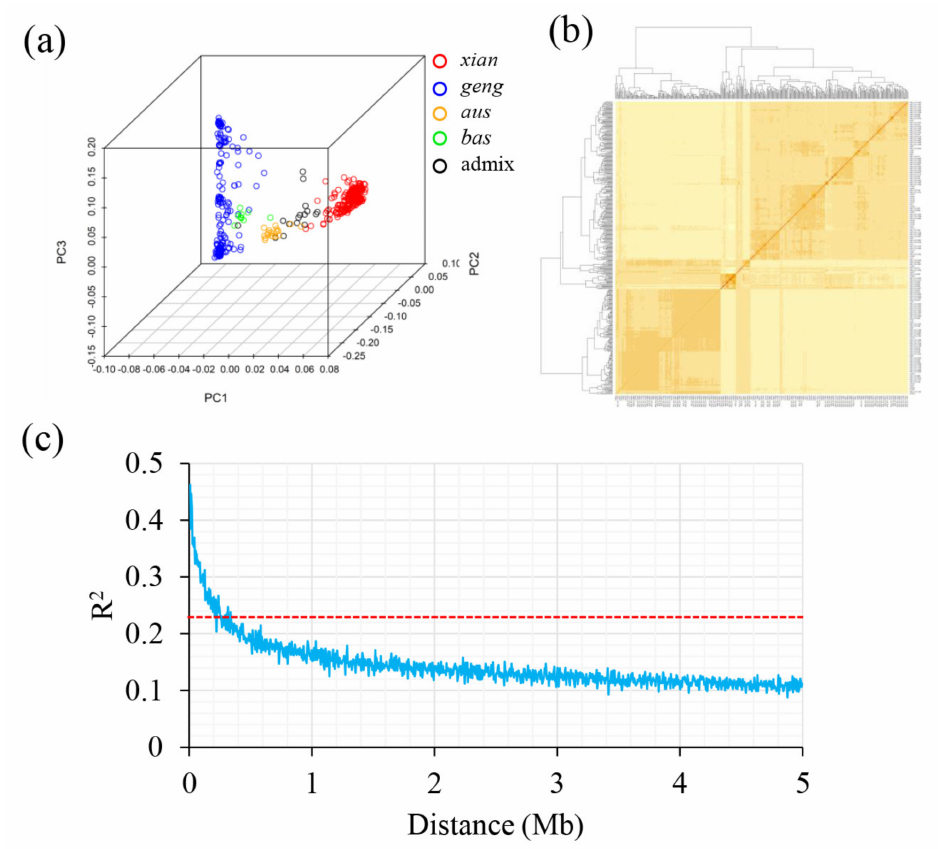
Figure 2. Genotypic analysis. ( a ) PCA plot based on the screen plot in the rice diversity panel. ( b ) Heat map of kinship with the tree shown on the top and left. ( c ) LD decay based on genotypic data in this study. The red line shows half of the maximum LD